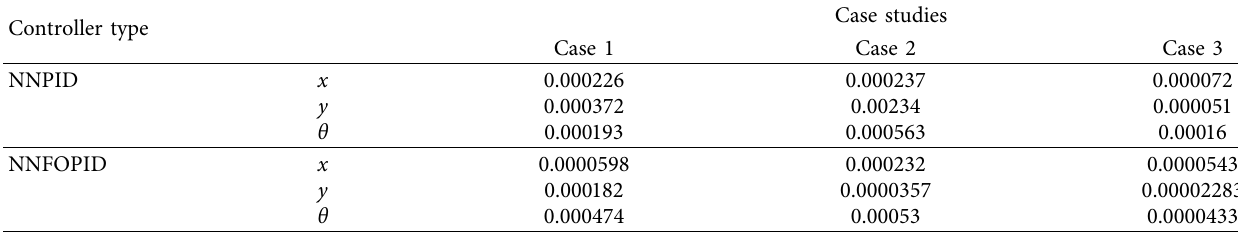
Table 5: The MSE of the position and orientation using MAPSO-EFFO algorithm.